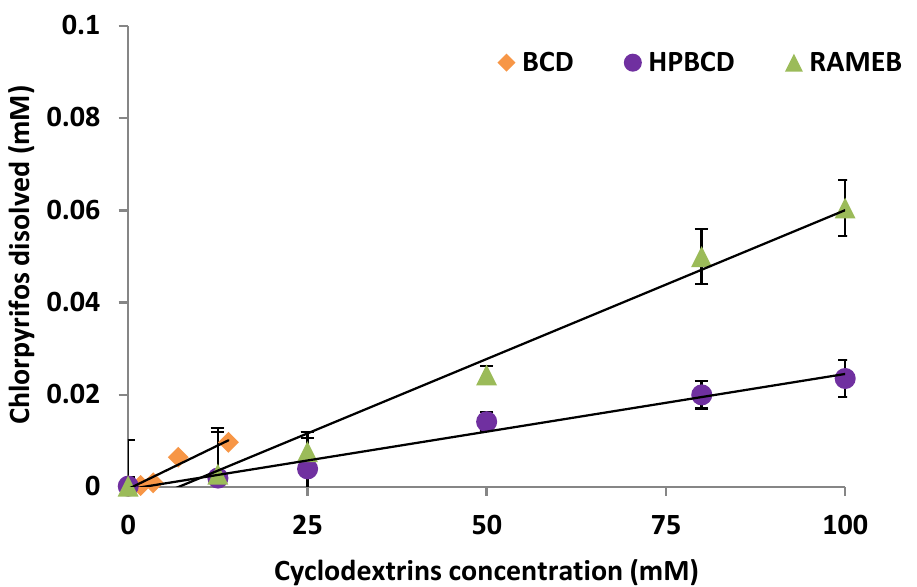
Figure 4. Chlorpyrifos phase solubility diagrams in the presence of the cyclodextrins studied.